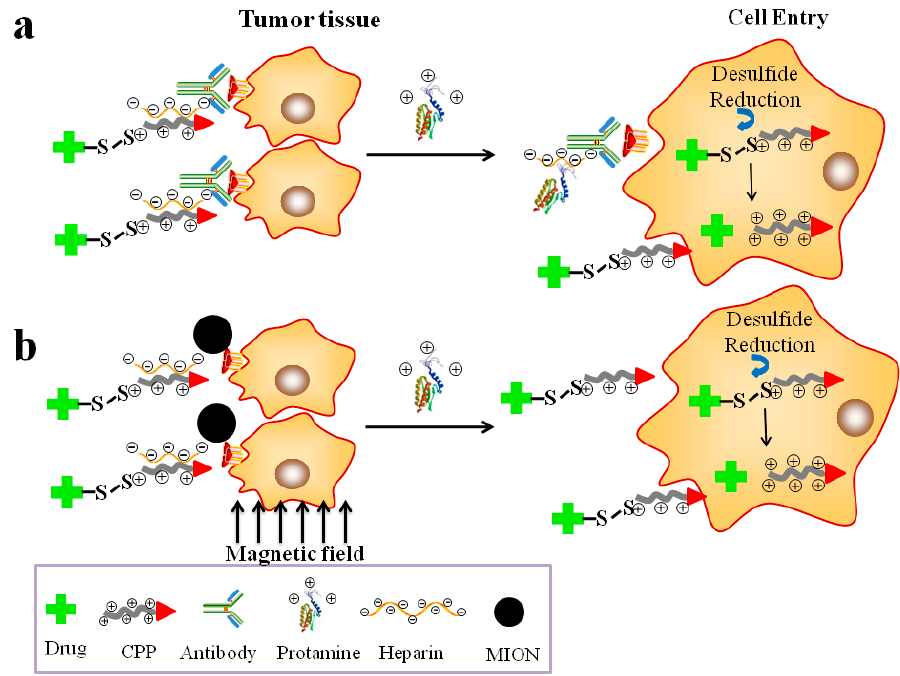
Figure 3. Illustration of the: ( a ) antibody-guided; and ( b ) Magnetic iron oxide nanoparticles (MION)-involved targeted drug delivery system (Reproduced according to [98,102]).